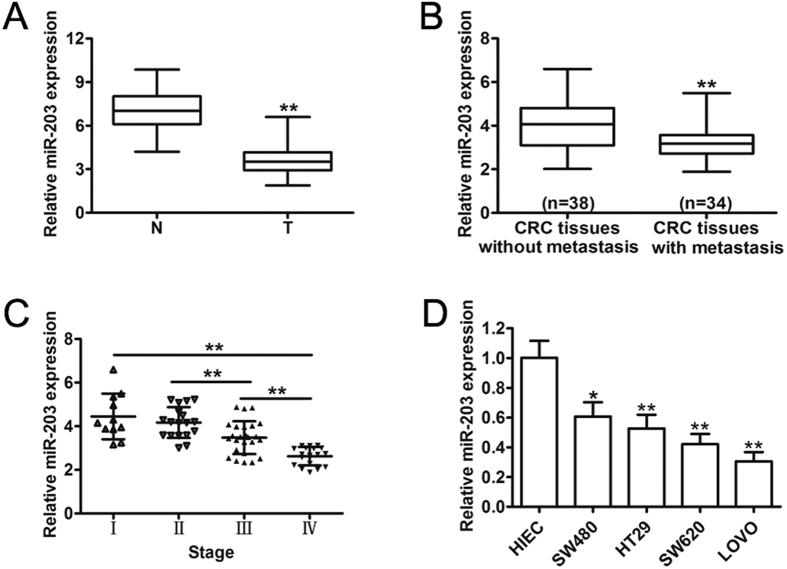
miR-203 was downregulated in the CRC clinical specimens and the human CRC cell lines.(A) miR-203 expression was determined by qRT-PCR in 72 pairs of CRC tissue (T) and the corresponding adjacent non-tumor tissue (N). (B) The miR-203 expression level was investigated in primary CRC tissues with metastasis or without metastasis. (C) Assessment of miR-203 levels from the total RNA derived from CRC tissues according to the tumor stage. (D) The relative expression of miR-203 in the CRC cell lines compared with the normal human intestinal epithelial cell line HIEC. *p < 0.05, **p < 0.01.